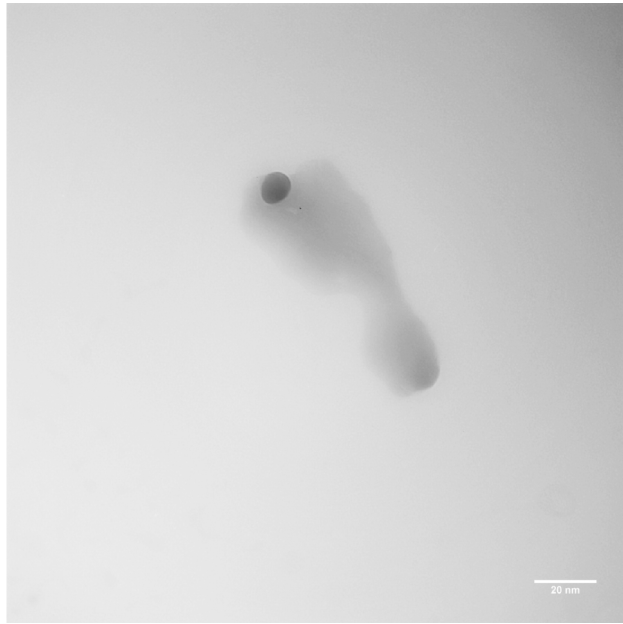
Fig. 1: The TEM image of Zn-salicylic acid